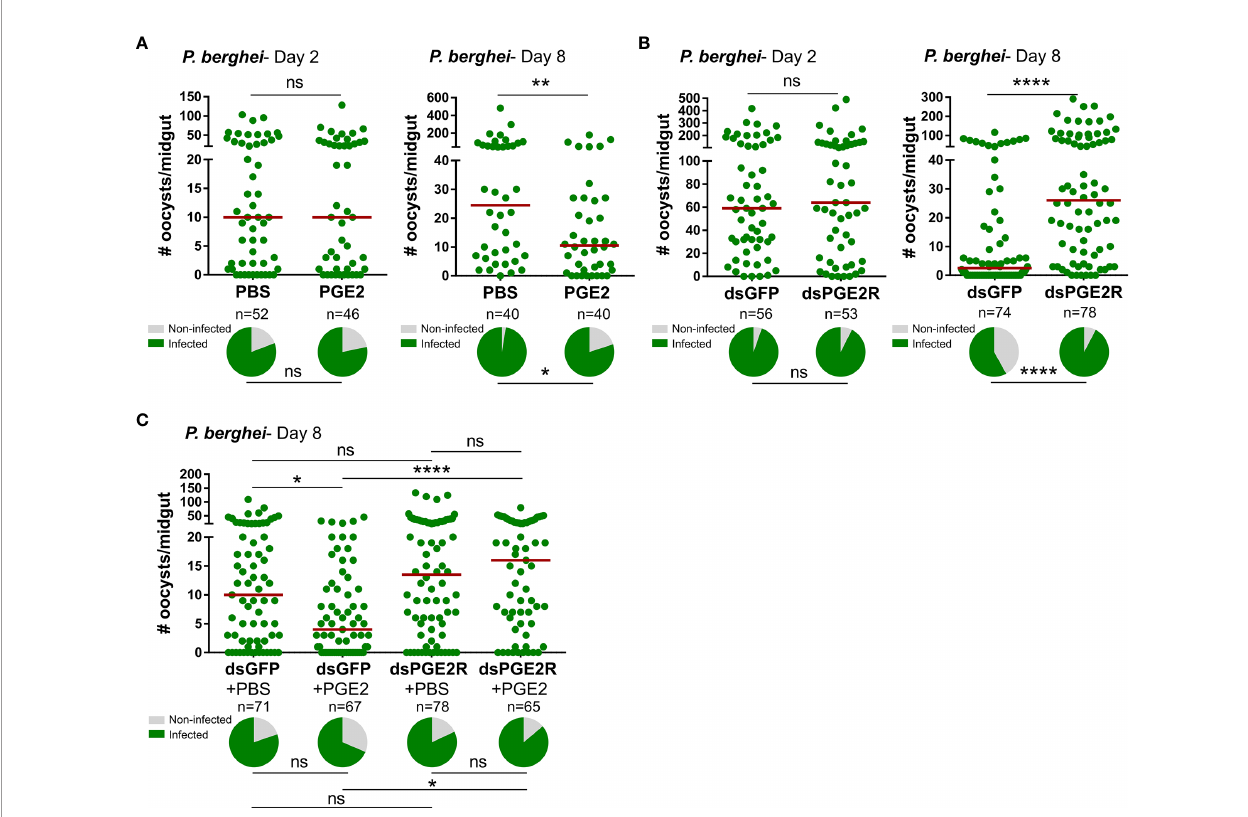
FIGURE 3 | PGE2 signaling mediates An . gambiae anti- Plasmodium immunity. Following priming with PGE2 (500 nM), P. berghei infection was measured by evaluating oocyst numbers at 2 days and 8 days post-infection (A) and compared to PBS controls. When AgPGE2R -silenced mosquitoes were challenged with P. berghei , early oocyst numbers (Day 2) were comparable to GFP controls, yet displayed signi fi cant differences at Day 8 (B) , reminiscent of previously described late- phase immunity phenotypes. When PGE2 was administered to GFP- and AgPGE2R -silenced mosquitoes, PGE2 priming signi fi cantly limited oocyst survival in control GFP mosquitoes, while there were no effects of PGE2 priming on oocyst survival in AgPGE2R -silenced background (C) . All infection data were analyzed by a Mann – Whitney test using GraphPad Prism 7.0. Median oocyst numbers from three or more independent biological replicates are indicated by the horizontal red line. The prevalence of infection (% infected/total) is depicted for mosquitoes under each experimental condition and examined by X 2 analysis to determine signi fi cance. Asterisks denote signi fi cance (* P < 0.05, ** P < 0.01, **** P < 0.0001); ns, not signi fi cant. n = number of individual mosquitoes